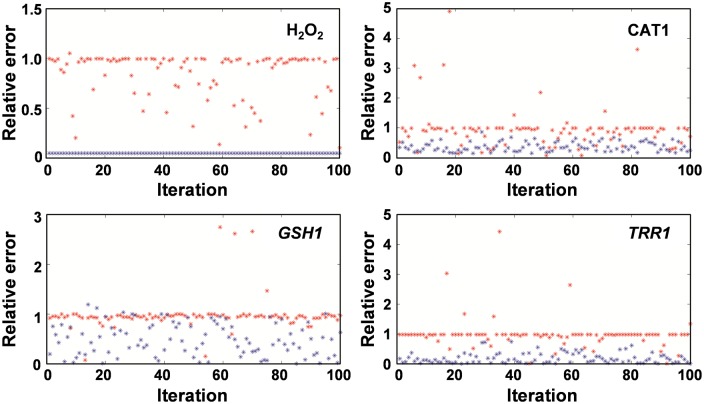
Permeability and mRNA induction rates are the most sensitive parameters of model.Relative error values in catalase (CAT1) at 10 min, TRR1 mRNA levels at 10 min, H2O2
Ex at 15 min, and GSH at 30 min estimated for 100 different parameter sets. Red points correspond to the case when the set of 73 key reaction rates were varied according a homogenous random distribution between 0.1 and 100 their nominal value, and blue points represents the case when both permeability and mRNA induction rates were fixed to their nominal values, whereas the rest of the parameters were randomly varied as above.